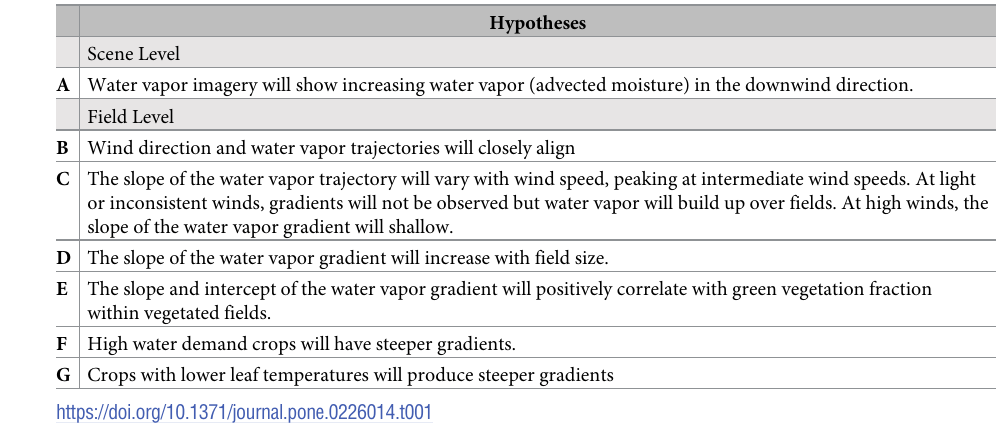
Table 1. Hypotheses to be tested in this